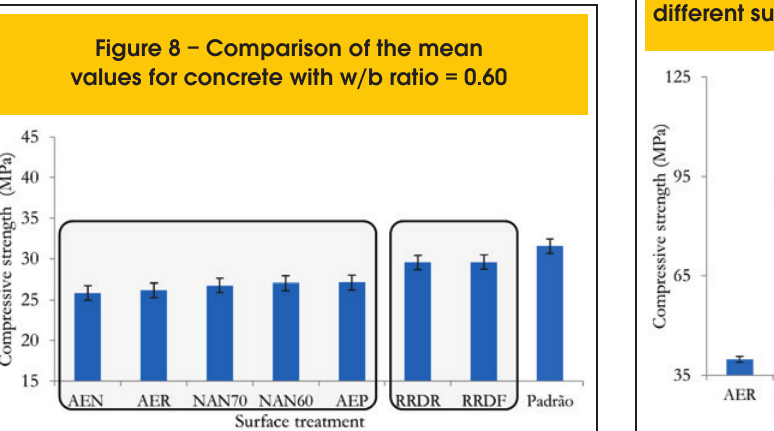
Figure 10 – Comparison of the mean values for different surface treatment types and w/b ratio =